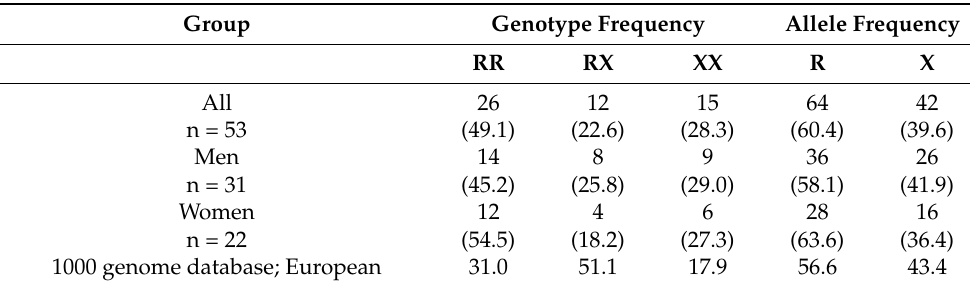
Table 1. Number (frequency, in %) of professional badminton players according to their ACTN3 genotypes (RR, RX and XX) and their allelic distribution (R and X), in comparison to the 1000 genome database of ethnically matched controls [31] (only frequency, in %).